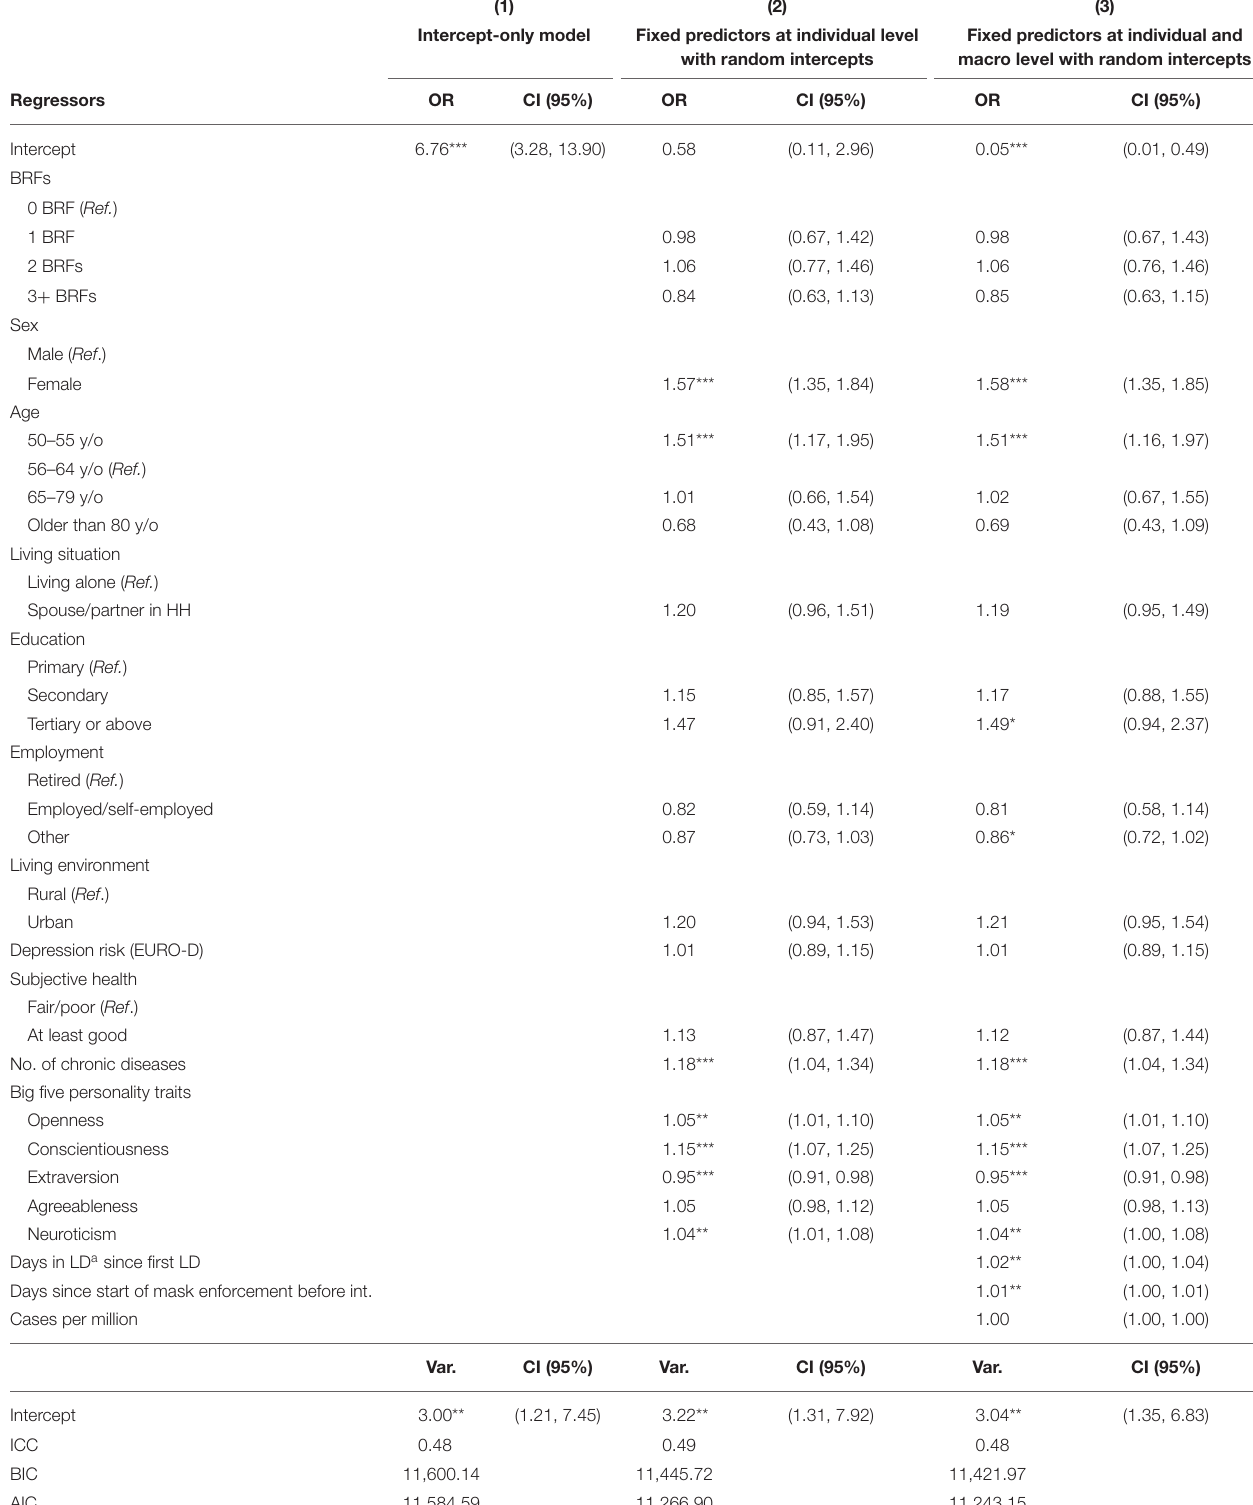
TABLE 5 | Multilevel analyses predicting adherence to regulated measures ( n = 17.588), Data: Wave 8 Release 0.0.1 beta. (1) (2) (3) Intercept-only model Fixed predictors at individual level Fixed predictors at individual and with random intercepts macro level with random